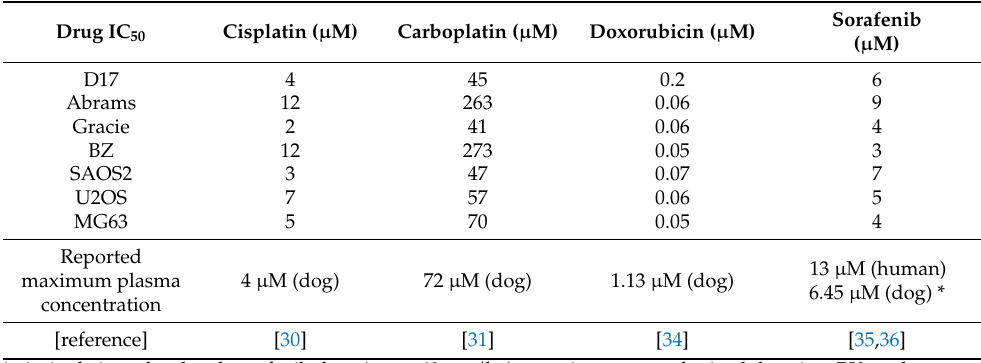
Table 1. The effects of sorafenib on cell viability and IC 50 s for sorafenib and three first-line OSA chemotherapy agents (cisplatin, carboplatin, and doxorubicin).